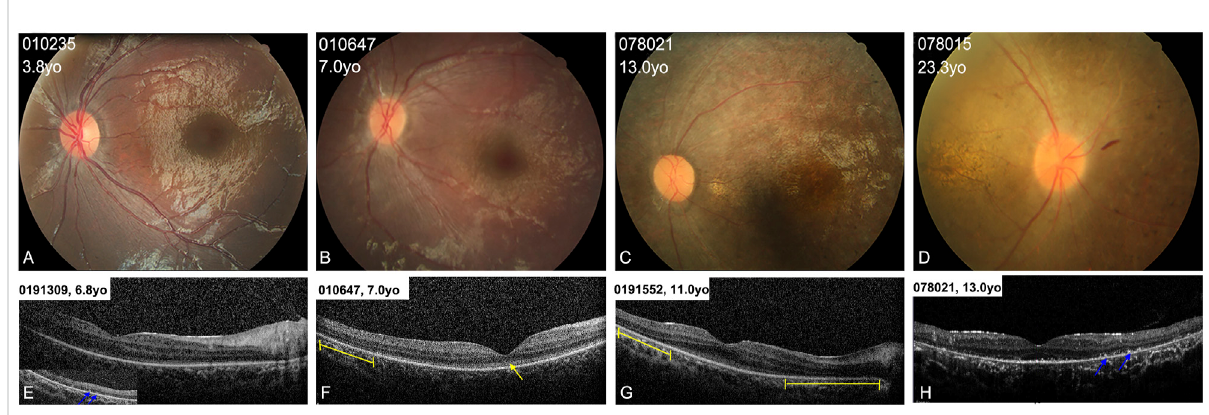
FIGURE 3 Colored fundus (CF) photographs and SD-OCT images of patients with typical retinal features. (A) CF images of patients younger than 5 years old (yo) show blunted foveal re fl ex and subtle RPE changes in the mid-periphery area. (B) CF photographs of patients aged from 5 to 10 years old show blunted foveal re fl ex, attenuated retinal vessels, and mild tapetoretinal degeneration in the mid-peripheral retina. (C,D) CF images of patients older than 10 years of age display a waxy-yellow optic disc, severe vascular attenuation, macular atrophy, and extensive retinal atrophy and clumping pigments in the mid-periphery area. (E – H) OCT scans of four patients show loss of the interdigitation zone, and coarse ellipsoid zone (EZ) inthemacula(yellow arrow),hyperre fl ective substance onRPE (bluearrows)intheperipheralretina, anddefectsoftheEZintheparamacularregion (yellow